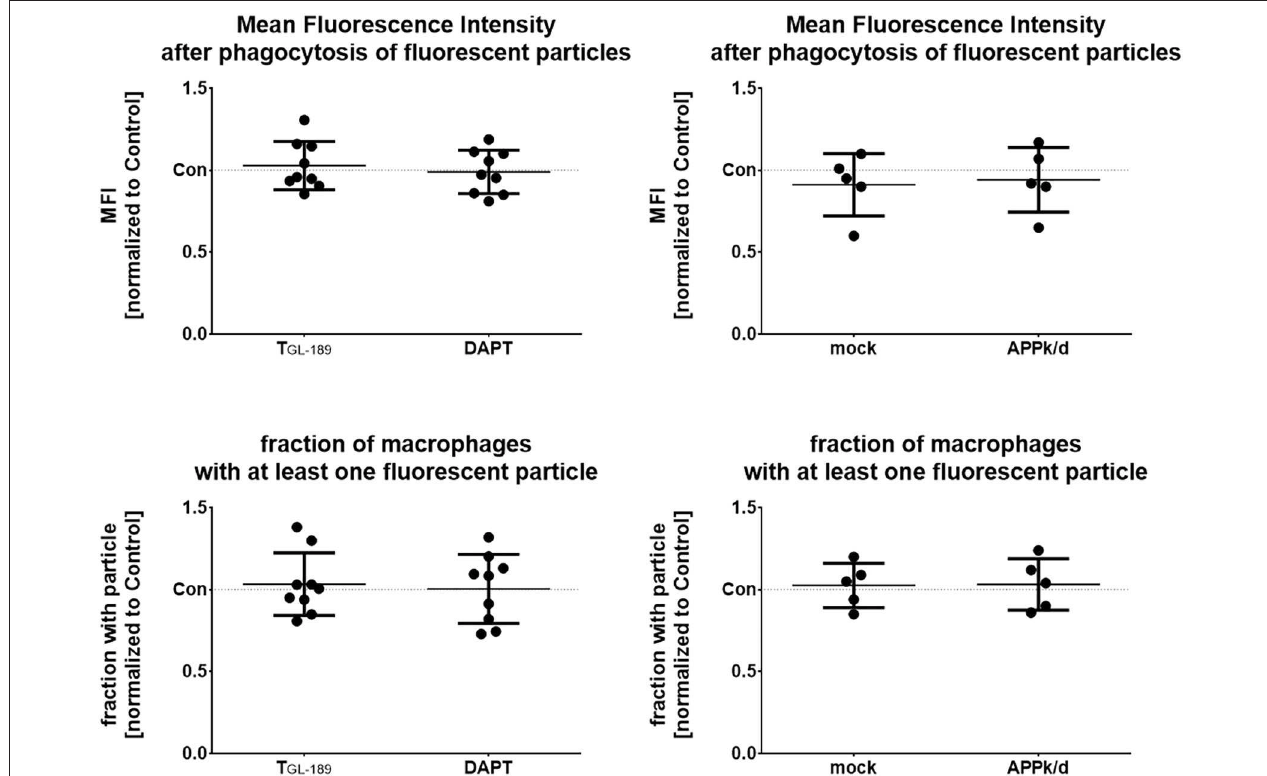
FIGURE 4 | No change of the phagocytotic activity after inhibition of APP processing or knock-down of APP. Macrophages were treated with 500nM of the β -secretase inhibitor T GL − 189 or 10 µ M of the γ -secretase inhibitor, DAPT ( n = 9). Alternatively, APP was knocked-down by siRNA ( n = 5). Phagocytotic activity of the macrophages was determined by flow cytometry 240min after addition of fluorescent 1 µ m polystyrene particles. Results are presented as mean with standard deviation of the measured mean fluorescence intensity (MFI) of the macrophages after phagocytosis. Measurements were carried out in duplicates. Each point represents a biological replicate and is the mean value of the duplicates. Phagocytosis was also evaluated by comparing the fraction of macrophages that contained at least one fluorescent particle normalized in the same